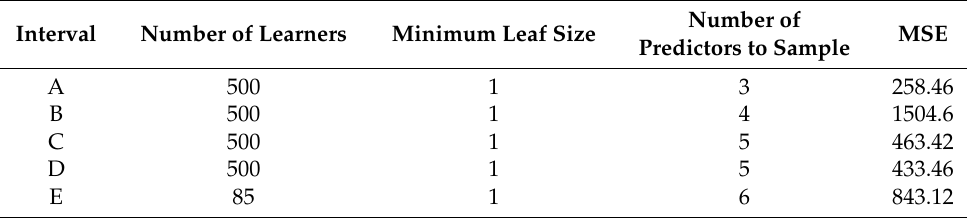
Table 1. Best settings for the algorithm in every considered interval.